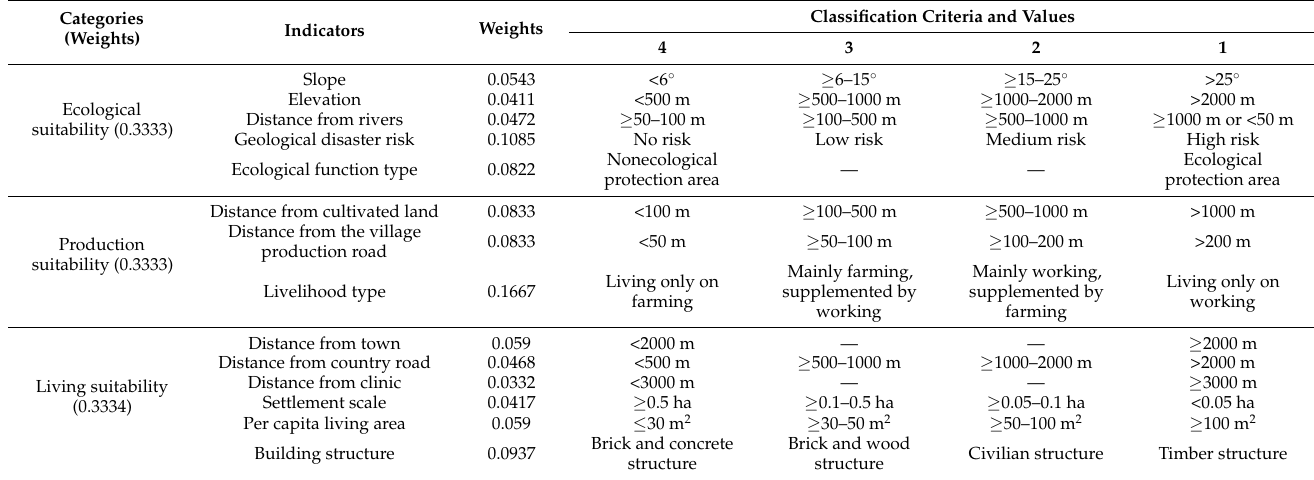
Table 1. Index system of multidimensional suitability evaluation of rural settlement